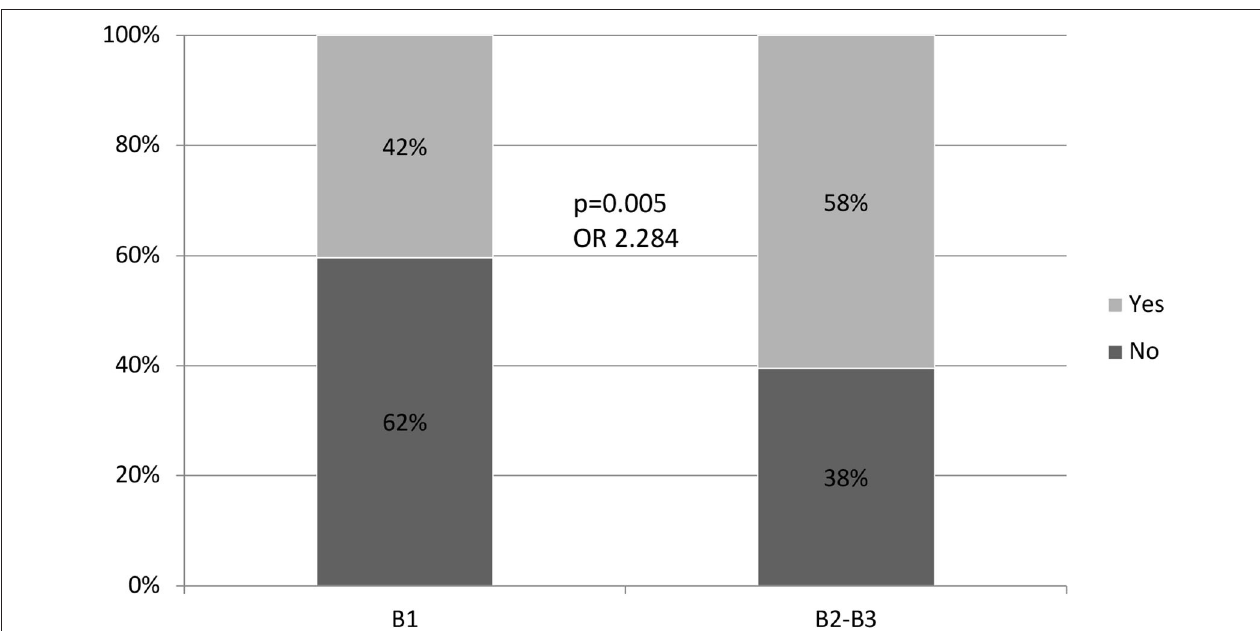
FIGURE 1 | Relation between the pattern of behavior and the need for treatment with